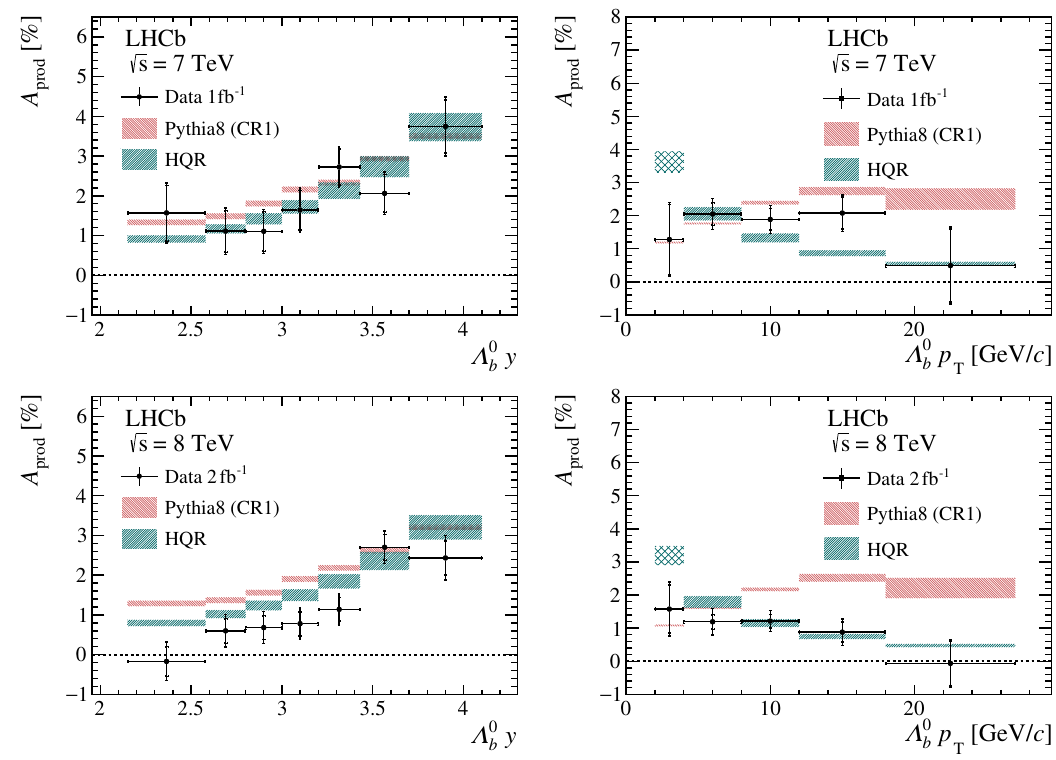
Figure 11 . Comparison of the measured (cid:3) 0 production asymmetry (points with error bars) with b the predictions by the most compatible Pythia model and the heavy-quark recombination model (HQR). Results versus (cid:3) 0 (left) rapidity y and (right) p T are shown for centre-of-mass energies of b (top) p s = 7 TeV and (bottom) p s = 8 TeV. Uncertainties for the CR1 Pythia model are due to limited simulation sample sizes. Those from the heavy-quark recombination model are systematic as provided by the authors, and have the results in the lowest p T interval hatched as the authors claim their results are reliable only for p T > 5 GeV/ c [4,